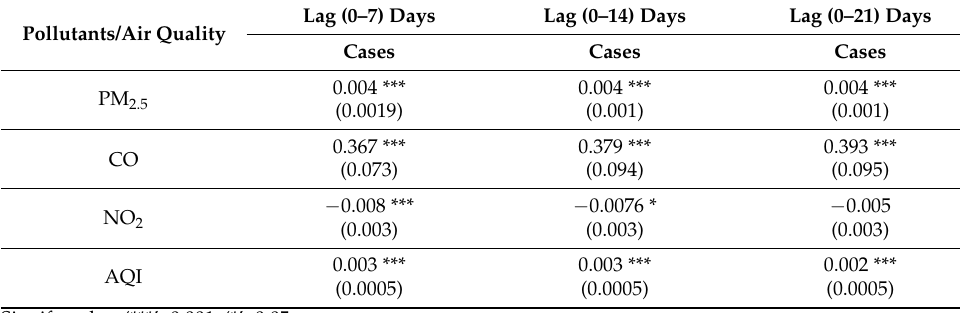
Table A2. GAM models after excluding Los Angeles County.